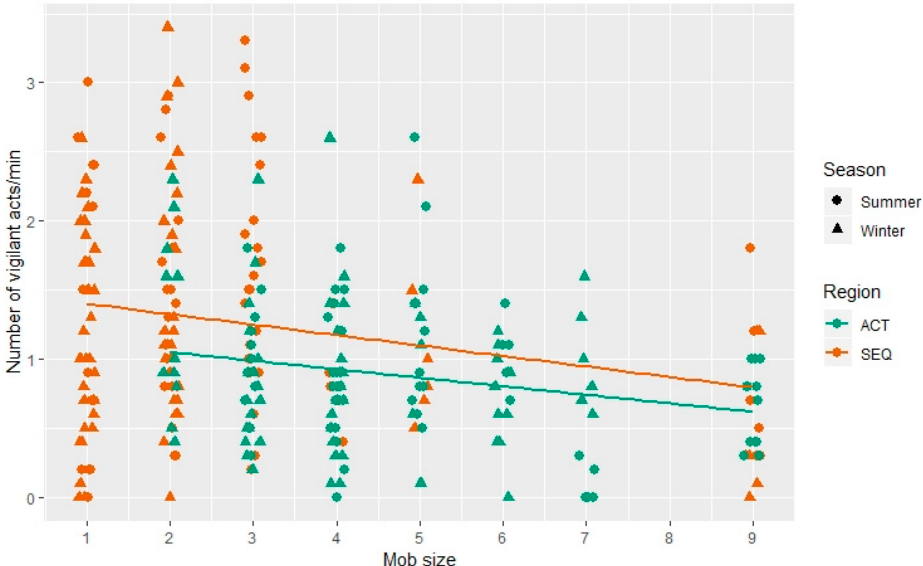
Figure 4. Frequency of vigilant acts per minute in relation to mob size of eastern grey kangaroos grazing in two different regions; south-east Queensland (SEQ) and the Australian Capital Territory (ACT) ( n = 284 individuals). Mob size is defined by categories: 1 (0–10), 2 (11–20), 3 (21–30), 4 (31–40), 5 (41–50), 6 (51–100), 7 (101–150), 8 (151–200), and 9 (over 200 individuals). 5 (41–50), 6 (51–100), 7 (101–150), 8 (151–200), and 9 (over 200